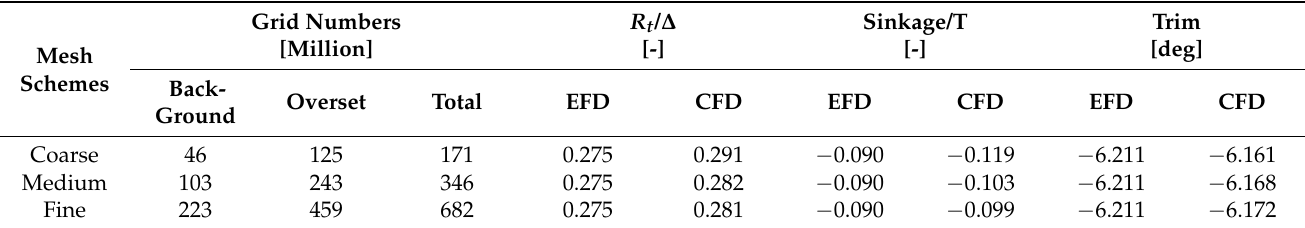
Table 2. The grid numbers and simulation results of three mesh schemes.